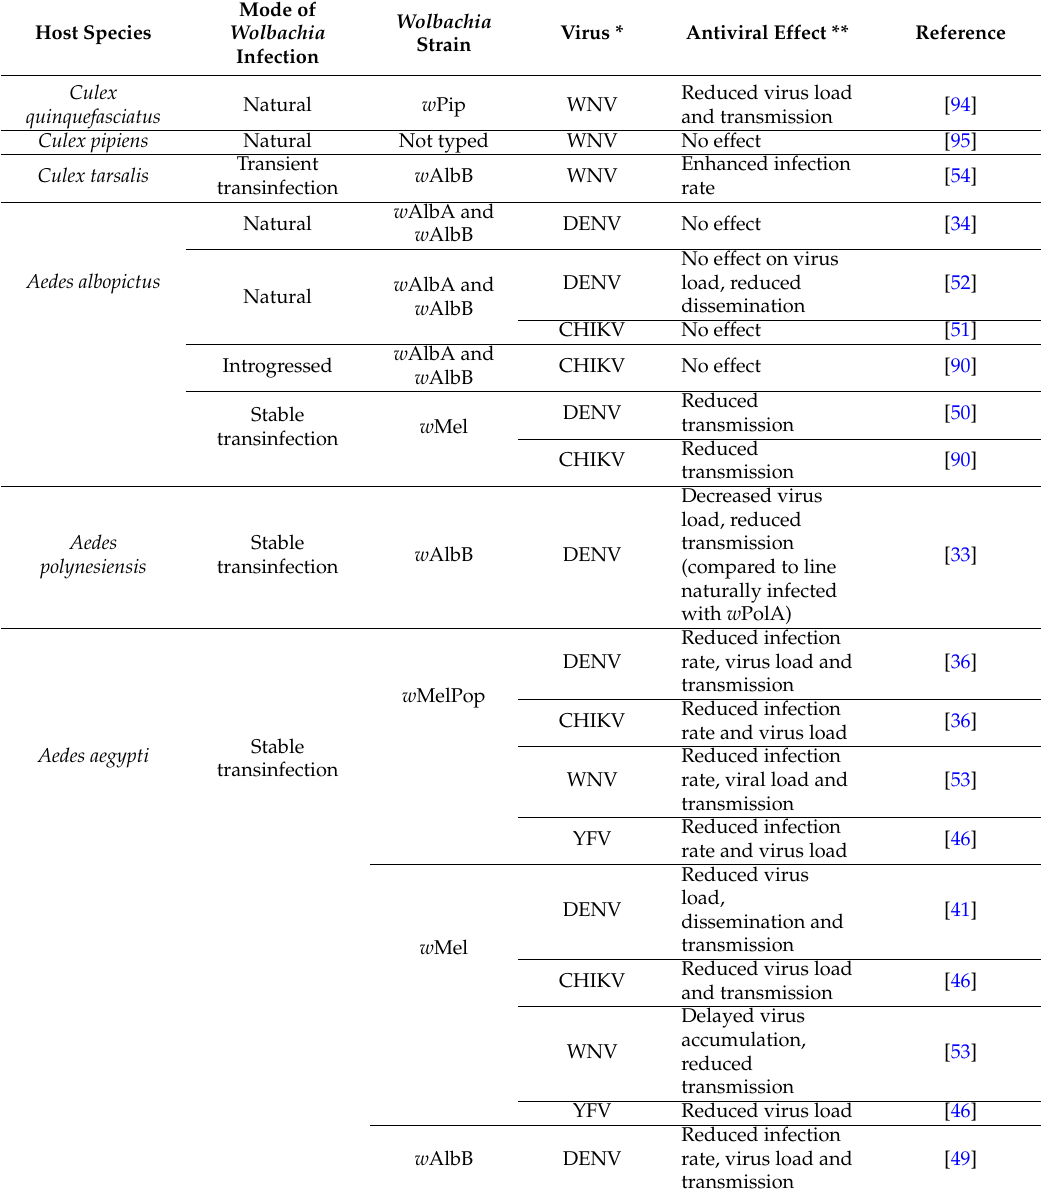
Table 2. Antiviral protection in mosquitoes naturally or artificially infected with